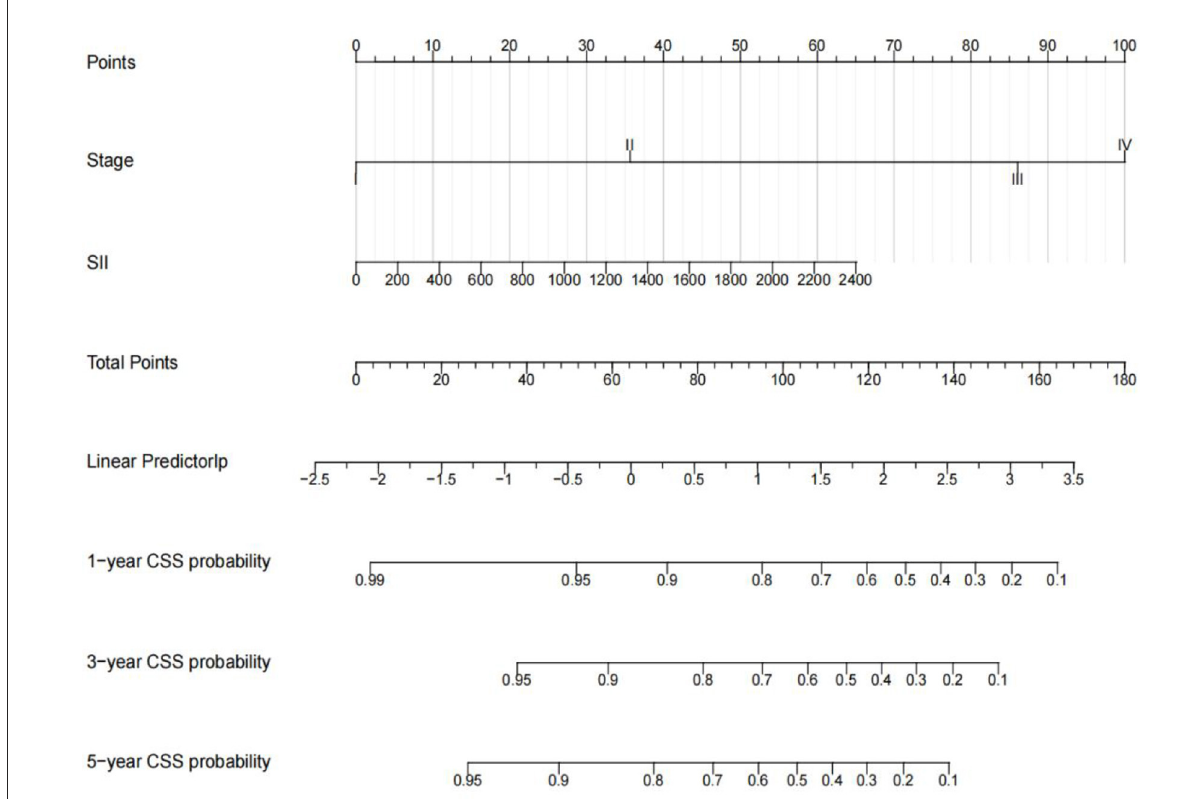
FIGURE5 Nomograms for 1-, 3-, 5-year CSS of children with OS. Input individual patient variables. Each variable corresponds to a point, and the point of all variables can be added to find the corresponding total point. Below the total point is the survival rate for each